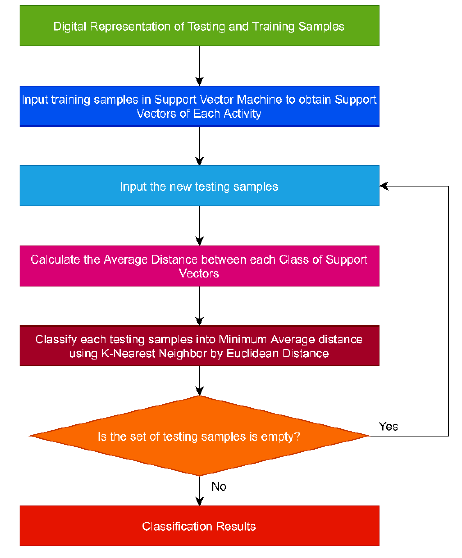
Figure 4. Hybrid Model of SVM – KNN